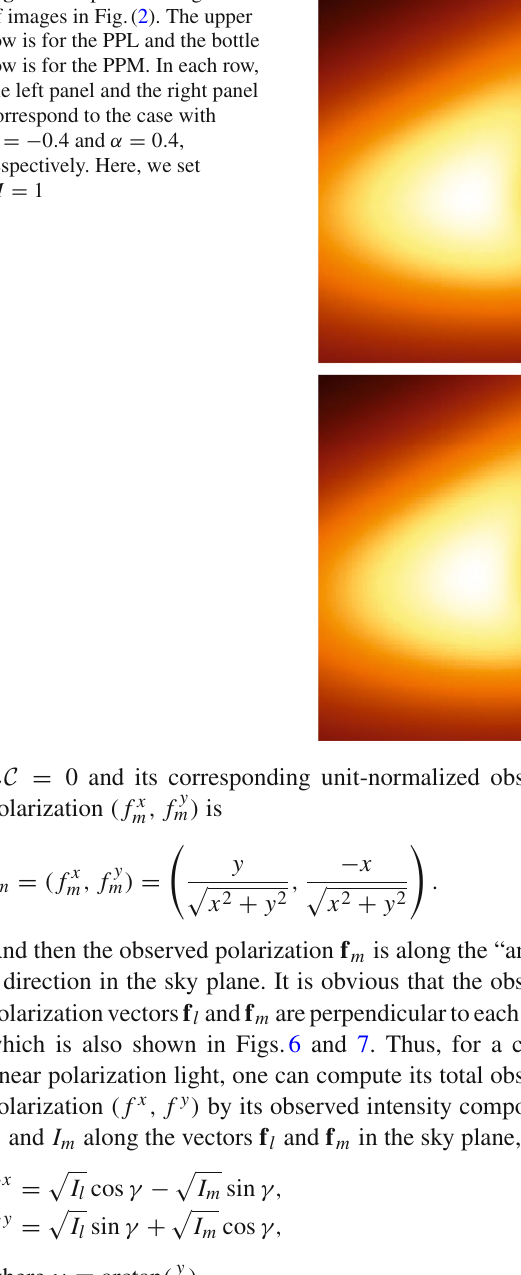
Fig. 3 The partial enlargement of images in Fig.(2). The upper row is for the PPL and the bottle row is for the PPM. In each row, the left panel and the right panel correspond to the case with α = − 0 . 4 and α = 0 . 4, respectively. Here, we set M =